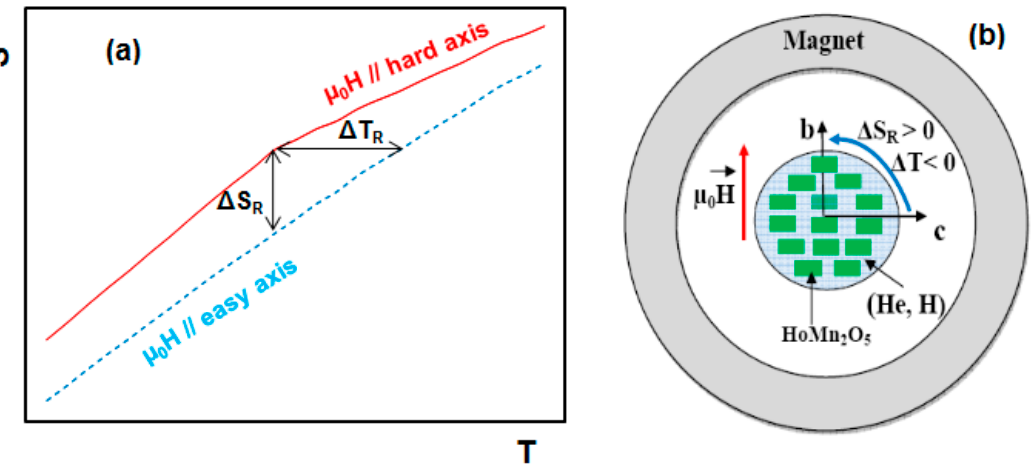
Figure 2. ( a ) Principle of the rotating magnetocaloric effect. ( b ) Generation of the magnetocaloric effect by rotating HoMn 2 O 5 single crystals between their easy (b-axis) and hard (c-axis) axes [19]. Helium and hydrogen gas can be then liquefied by using them as heat transfer fluids [19].